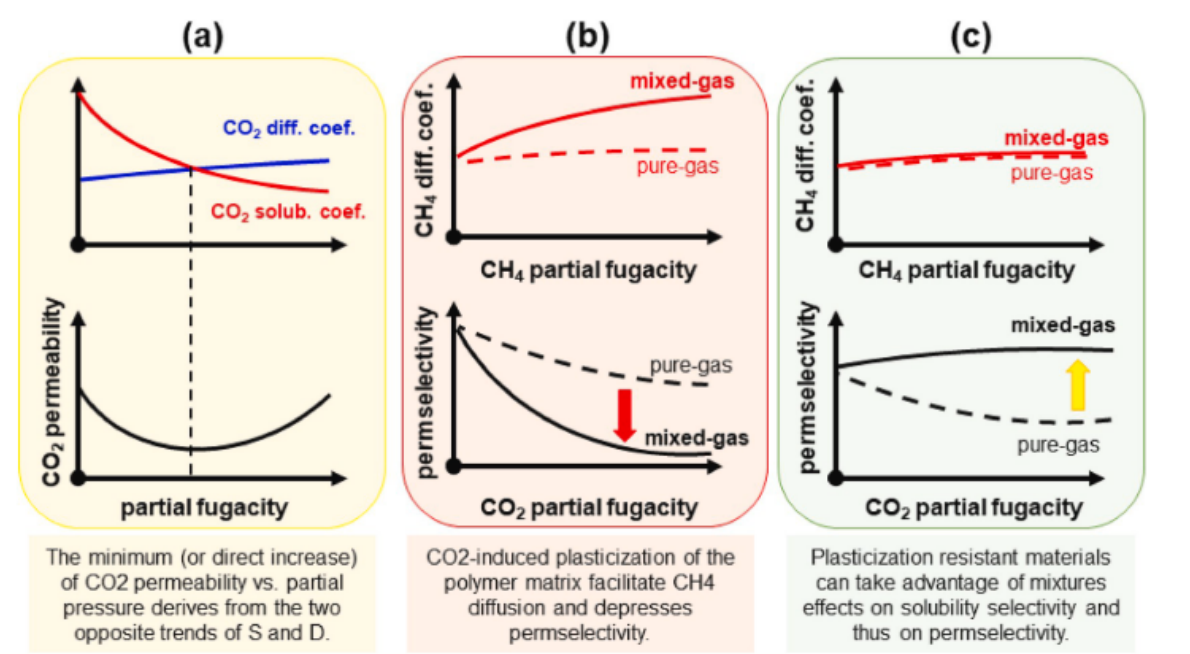
Figure 3. ( a ) CO 2 permeability of CTA; ( b ) plasticization phenomena ( c ) the behaviour of plasticiza- tion resistant polymers [47].